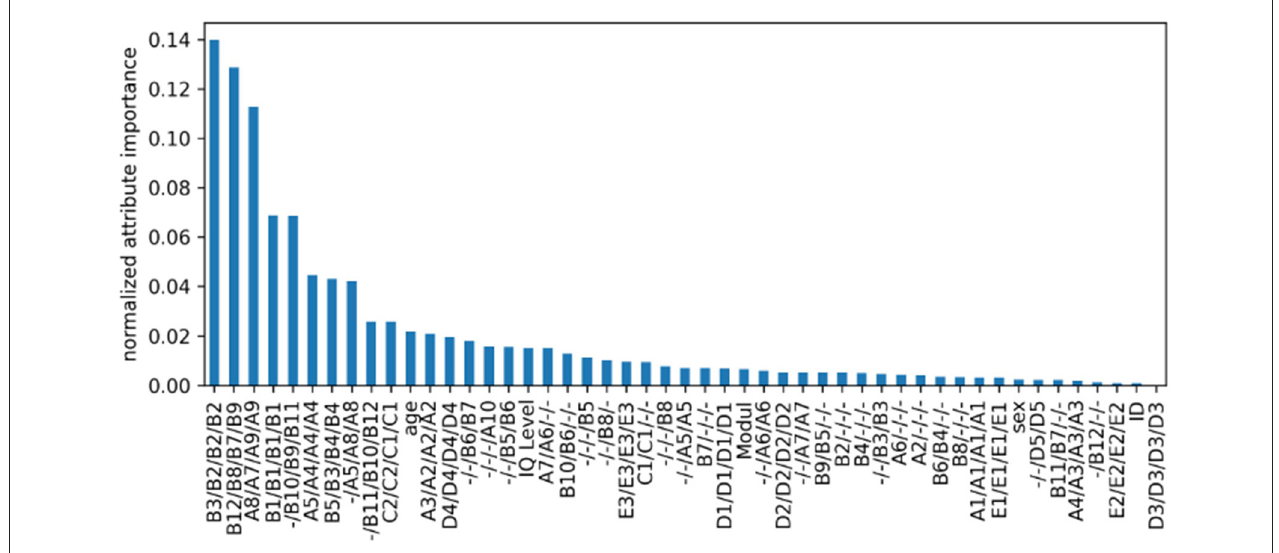
FIGURE 3 | Decision tree with optimal parameters, trained on the full dataset. Its in-sample accuracy (i.e. on the training data/the full dataset) is 84.08%. Samples are passing the tree from top to bottom. If the conditional test associated with a node is passed, the left child-node will be visited, else the right node. Furthermore, the number of samples, proportion of ASD samples in the training set are given as well as the estimated class. The color codes the “purity” of the sample: From blue (100 % ASD) over white (50% ASD) to orange (0% ASD). For the ADOS-items, the names of corresponding items in all four different modules are given, separated by “/”. If no corresponding item for a given module could be found, they are marked as